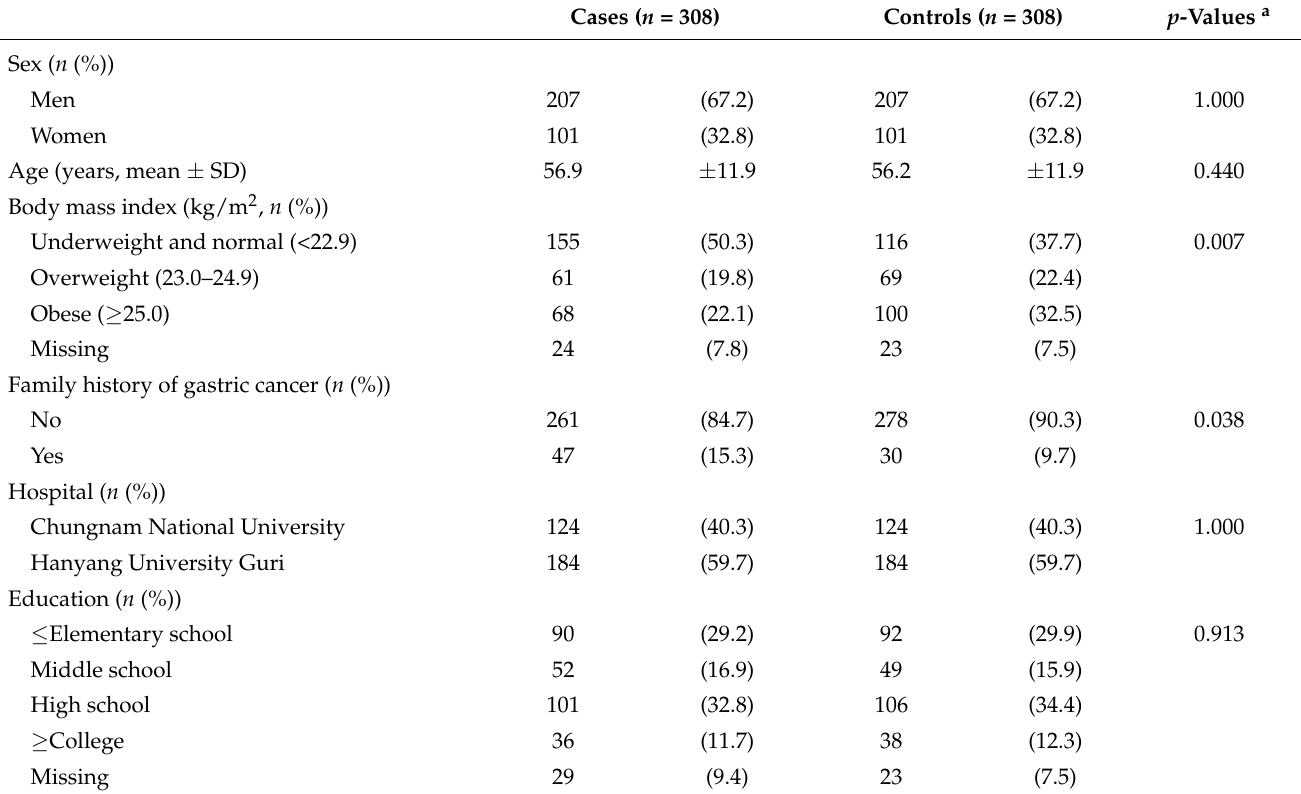
Table 1. General characteristics according to gastric cancer cases and